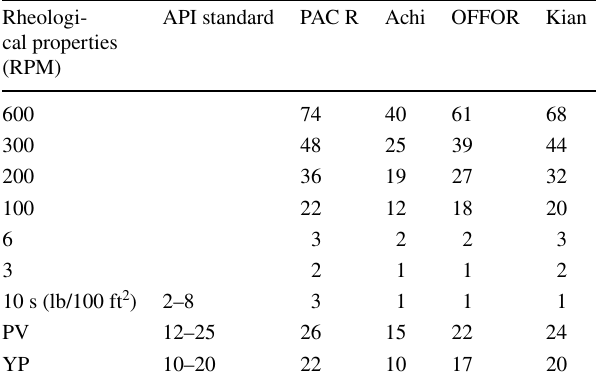
Table 2 Rheological analysis for the water-based mud using the vis- cosifiers